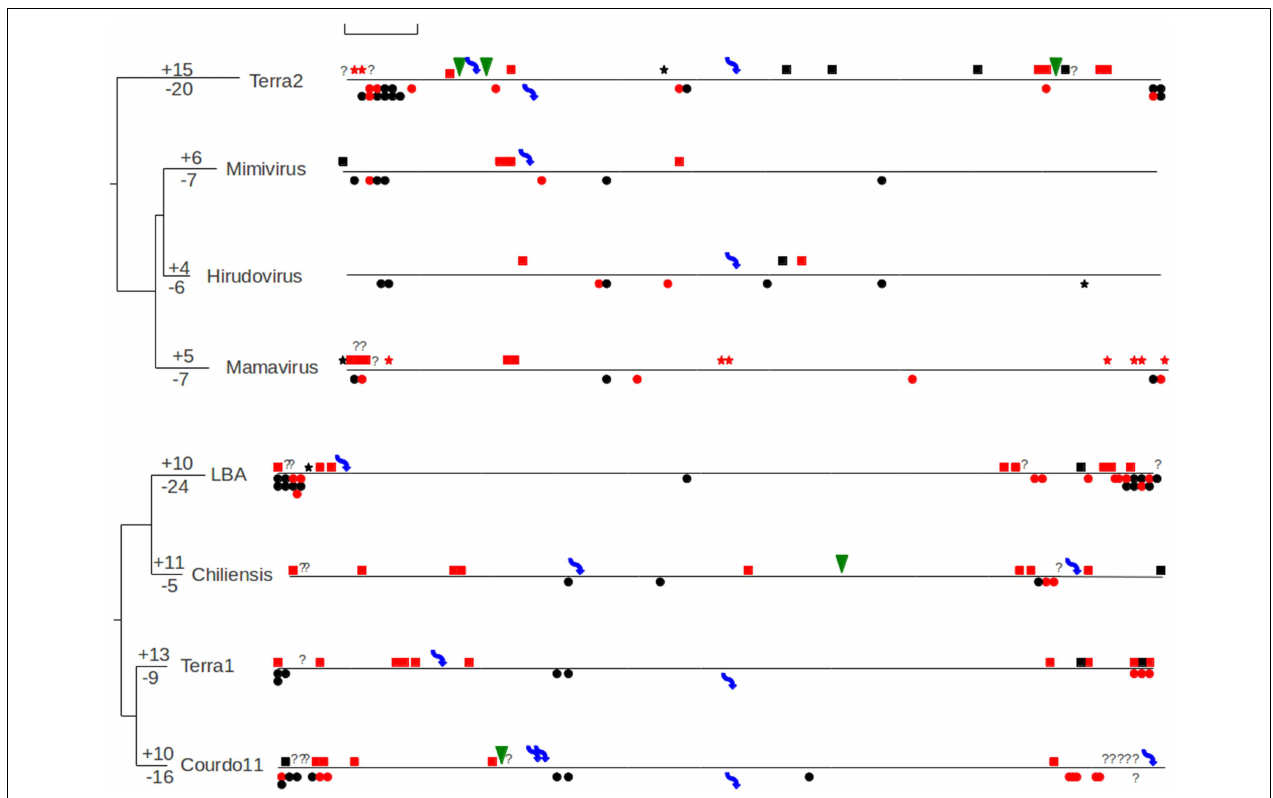
and arrows for insertion of mobile genetic elements). Interrogation marks represent ambiguous cases or presence of orphans. Squares and dots in red indicate genomic events of genes belonging to paralogous families. The trees represent the whole genome phylogeny, the numbers above and below the terminal branches indicate the amount of gene gain and loss for each virus. The scale bar represents the equivalent of